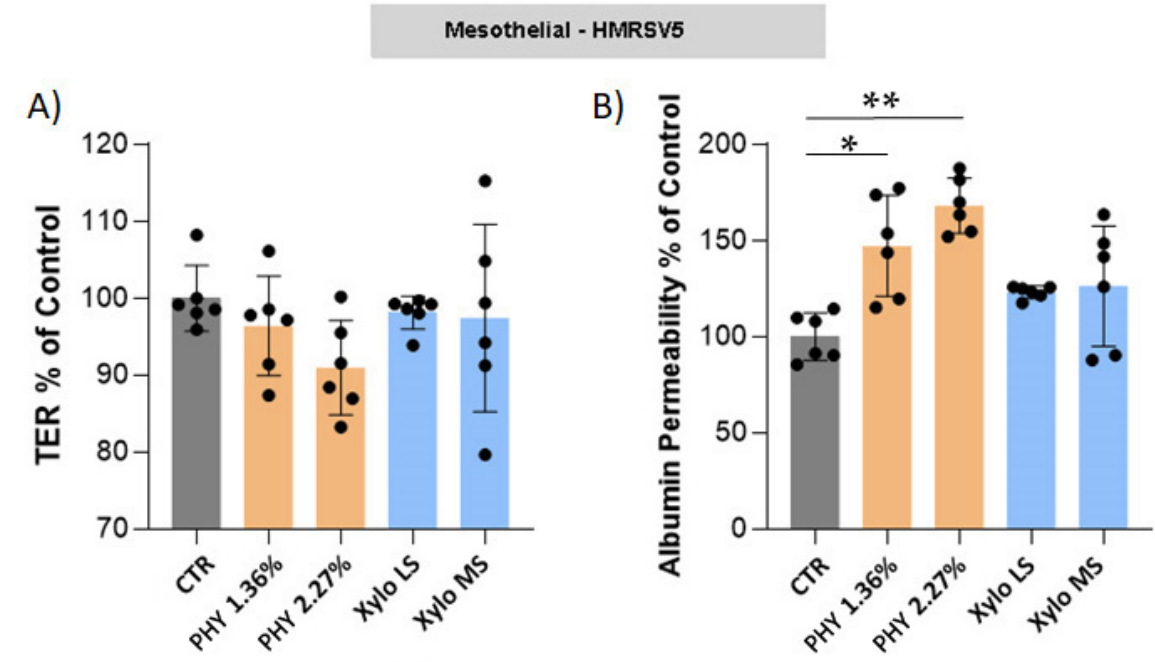
Figure 4. Mesothelial TER and permeability. ( A ) TER and ( B ) albumin permeability were measured in HMRSV5 mesothelial cells grown with or without different PD solutions. Graphs represent mean ± standard deviation (error bars) ( n = 6 biological replicates). ( B ) CTR vs. PHY 1.36% p = 0.0025, CTR vs. PHY 2.27% p < 0.0001. * p < 0.05, ** p < 0.001.